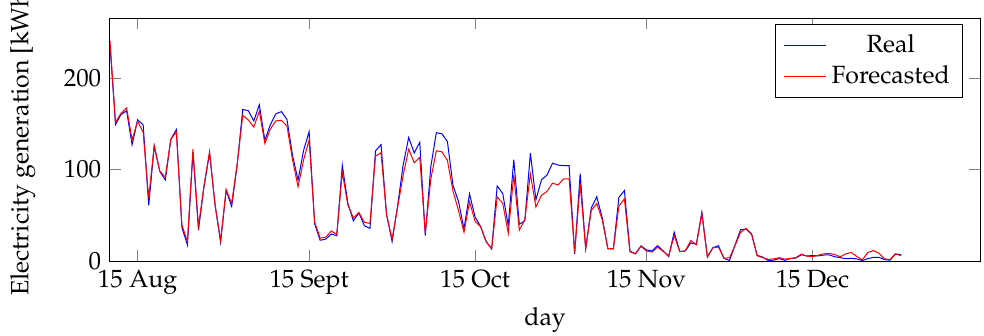
Figure 8. Forecasting results for 10 August to 31 December 2021 using ANN.